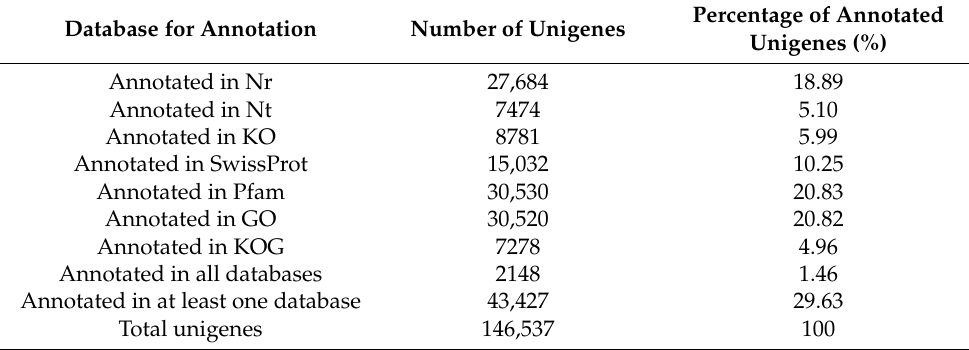
Table 3. Statistics of unigene annotations based on each of the seven databases. Database for